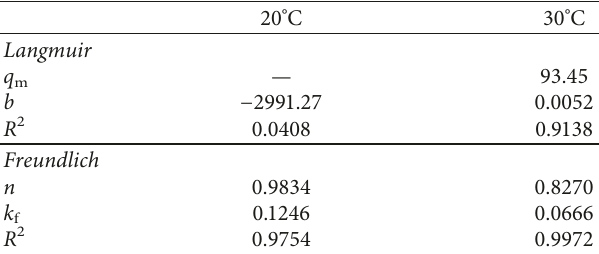
Table 3: Parameters of Langmuir and Freundlich